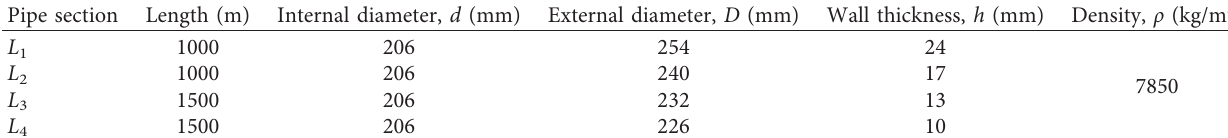
Figure 2: The mechanical model of the lifting pipe subsystem under the action of ocean current. (a) Mechanical model. (b) Forcemicro element. (c) DVA. Table 1: Basic parameters of the lifting pipe subsystem.